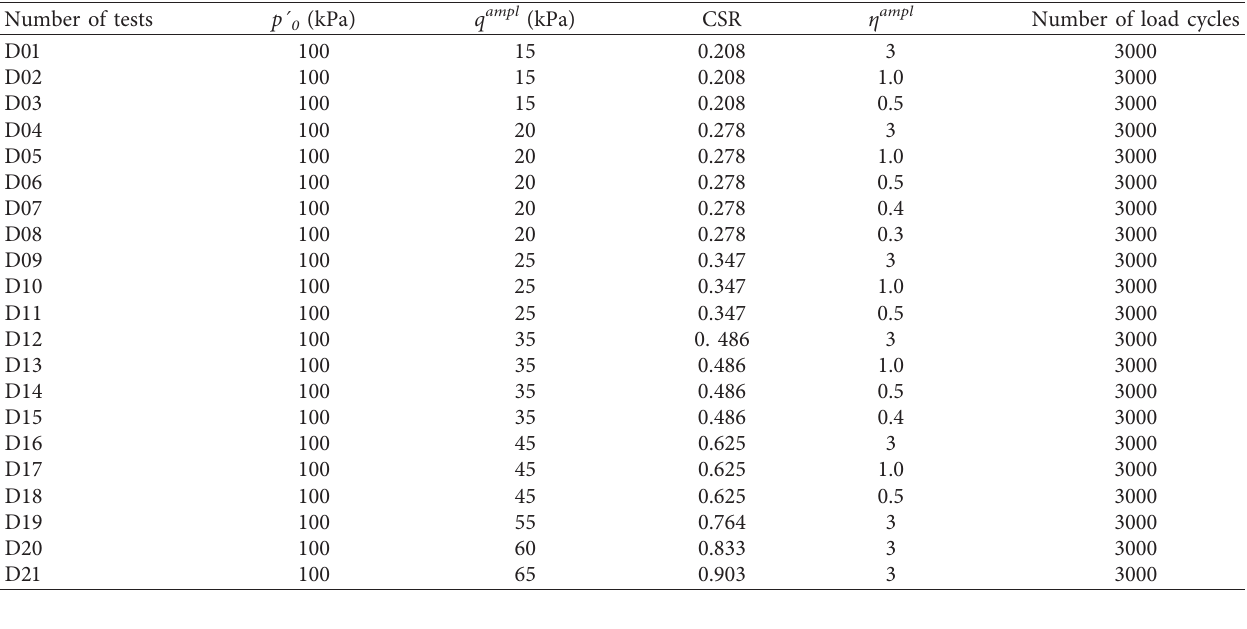
Table 2: Scheme of CCP and VCP tests.